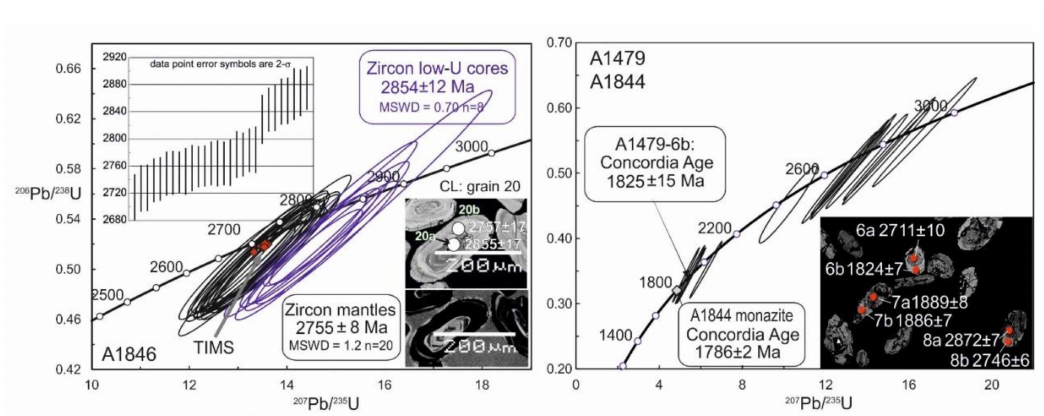
Figure 9. Concordia diagrams for zircon in the trondhjemitic gneiss sample A1846 and the pegmatite sample A1479 and monazite in the leucosome sample A1844. Datapoint error ellipses are 2 σ , the blue ellipses are for the older age group grains and the black for the younger. The boxes show the average 207 Pb / 206 Pb ages for both age groups. The upper left corner inset shows the distribution of the 207 Pb / 206 Pb ages. The CL image in the lower right corner of the A1846 figure shows the grain 20 (Supplementary Materials, Figure S4) that has a 2.86 Ga core with a 2.76 Ga rim. The CL image in the lower right corner of the A1479-A1844 figure shows the grain 6 (Figure S4) that has an Archean core with a 1.82 Ga